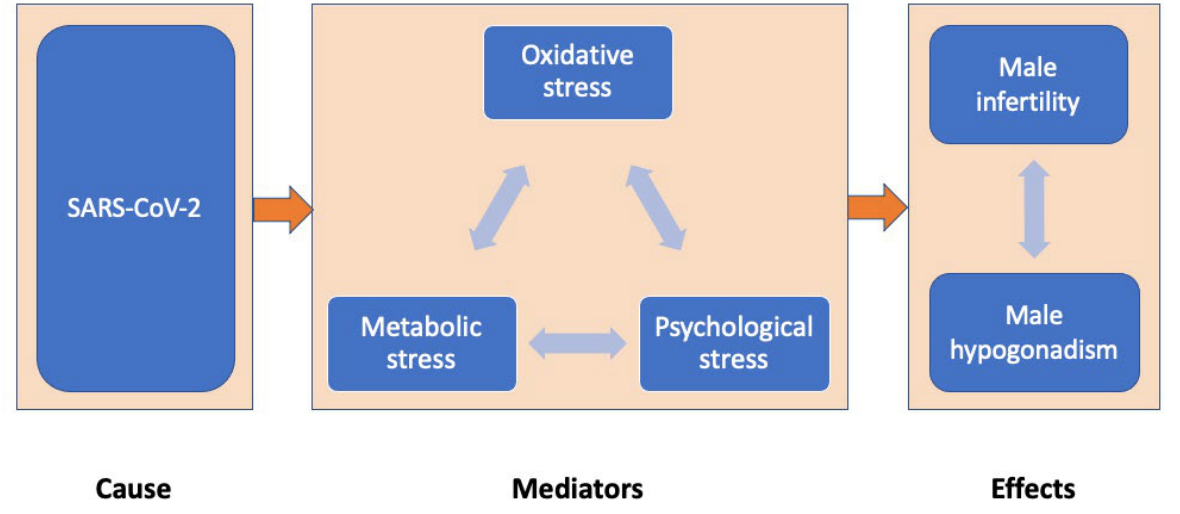
Figure 1. The impact of COVID-19 on male reproduction (via effects on testosterone secretion or semen parameters) through oxidative, metabolic and psychological stress mediators.